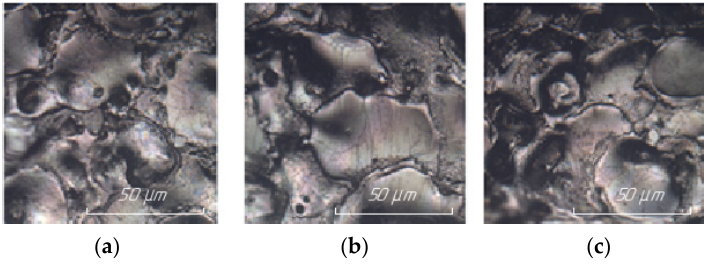
Figure 10. Surface of steel 15 at 200 × magnification after EDM in ET finishing mode from: ( a ) copper; ( b ) graphite; ( c )